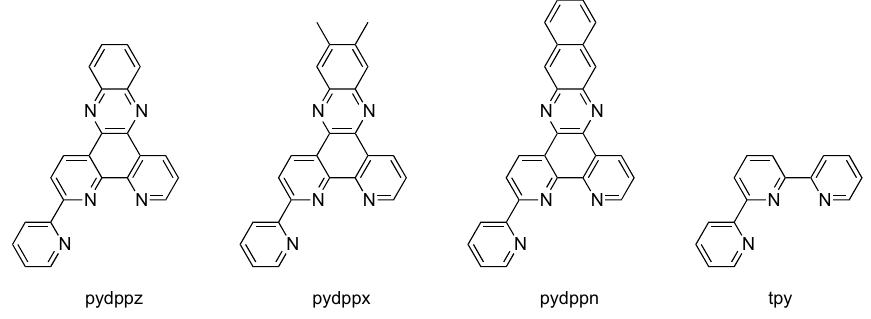
Figure 13. Tridentate ligands used in the studies performed by Turro.